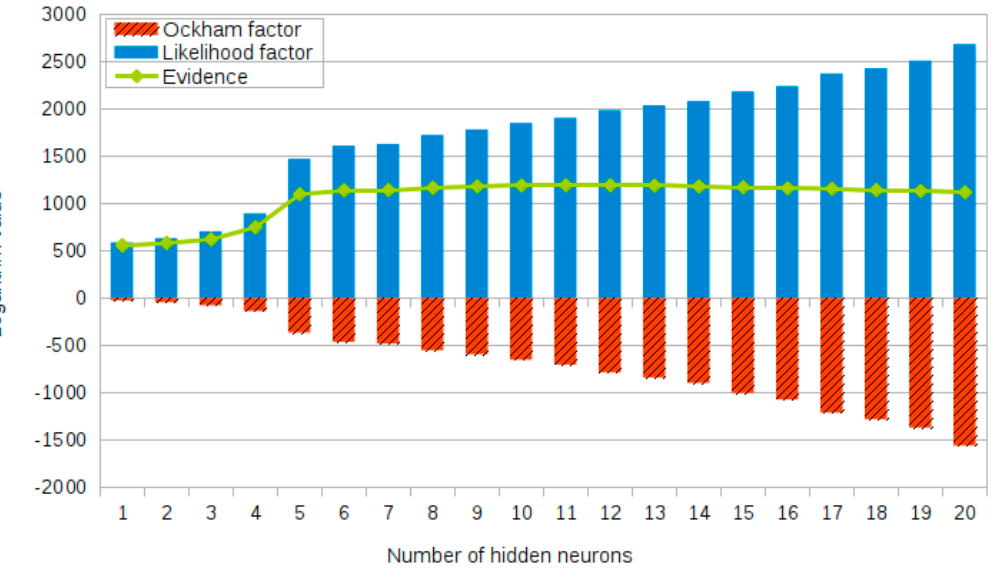
Figure 6. Logarithm value of likelihood factor, Ockham factor and evidence. Table 3. The results of model class selection for the Bayesian neural